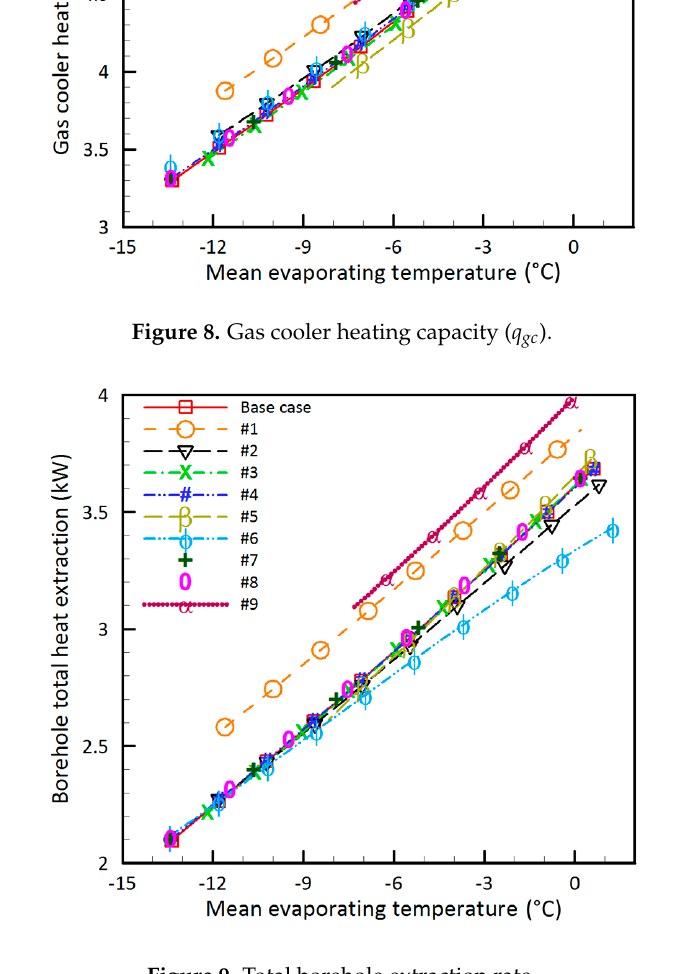
Figure 9. Total borehole extraction rate.